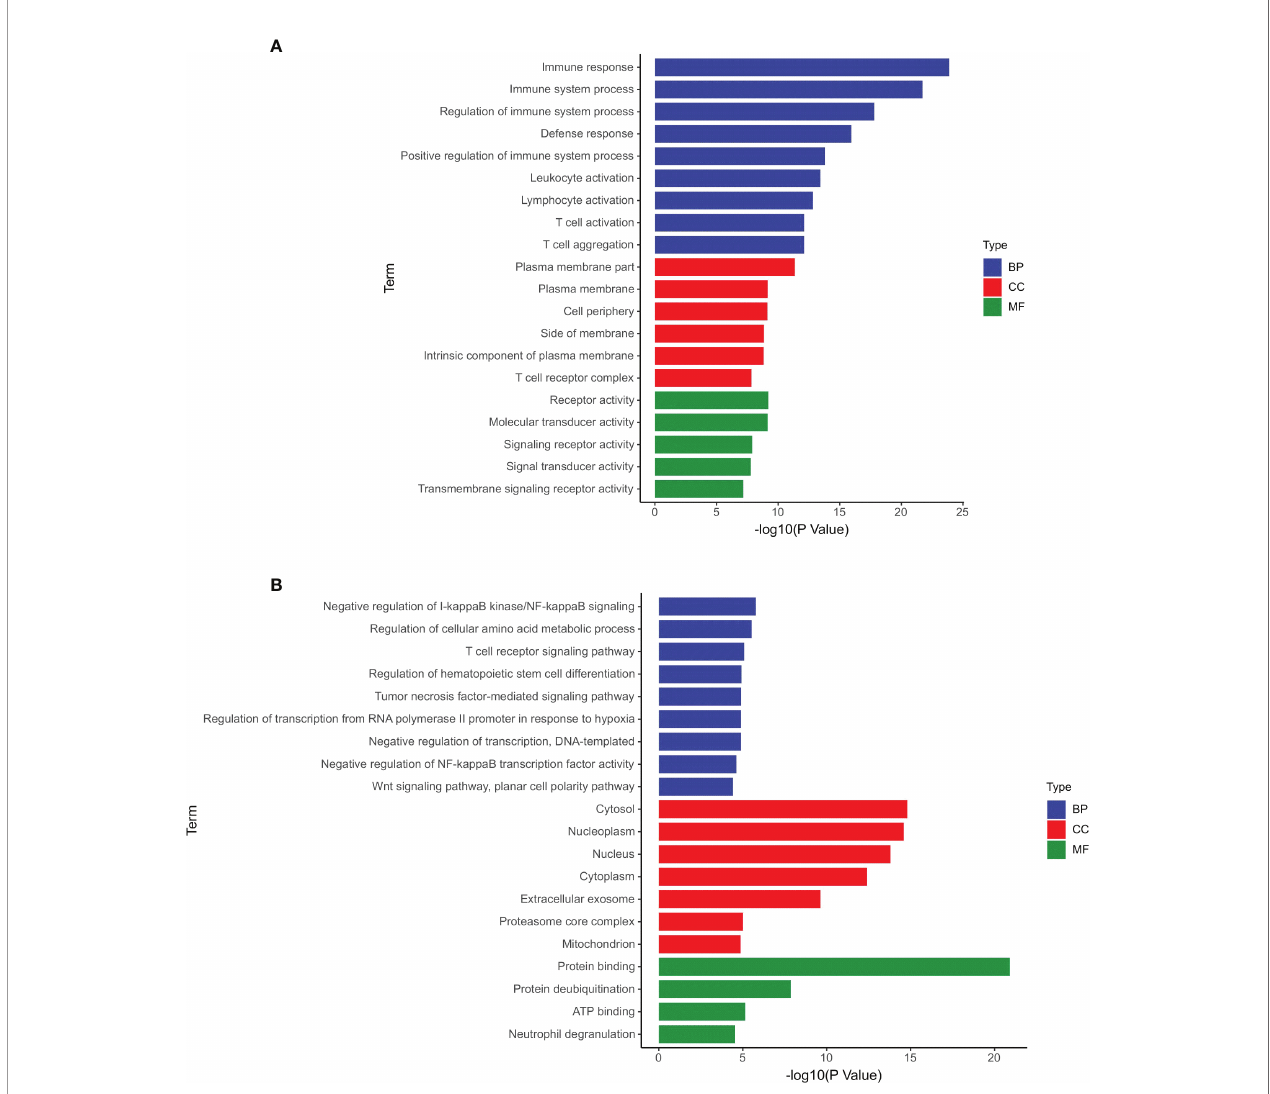
FIGURE 1 | GO terms of the differentially expressed mRNAs and circRNAs. (A) Differentially expressed mRNAs; (B) differentially expressed